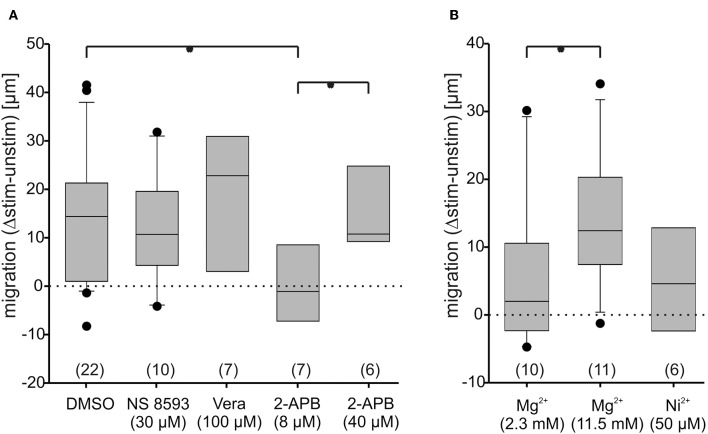
Osteoblast migration speed changes under blockade of transmembrane Ca2+-conductances and under activation of store-operated channels. Changes of anodal migration speed are given as differences between migration with and without DC-stimulation (Δstim.-unstim.), given as box plots. The dotted lines represent no net movement change. In a fist set of experiments (A), the role of TRPM7 gating (blocked by NS 8593, 30 μM), of L-type Ca2+-channel ion flux (blocked by verapamil; Vera, 100 μM), of store operated channels (activated by 2-APB, 8 μM) and of endoplasmic reticulum IP3-receptor function (blocked by 2-APB at 40 μM) was compared to DMSO (solvent of the drugs at 0.1%) as control. In a second set (B), the role of T-type Ca2+-channel ion flux (blocked by Ni+, 50 μM) and of transmembraneous Ca2+-flux as a whole (blocked by 11.5 mM Mg2+) was compared to conditions in normal extracellular Mg2+ concentration (2.3 mM). The number of experiments is given in brackets. Each experiment was conducted on 20–40 cells per group. *Denote significant differences in Mann-Whitney U-test, with p < 0.05.